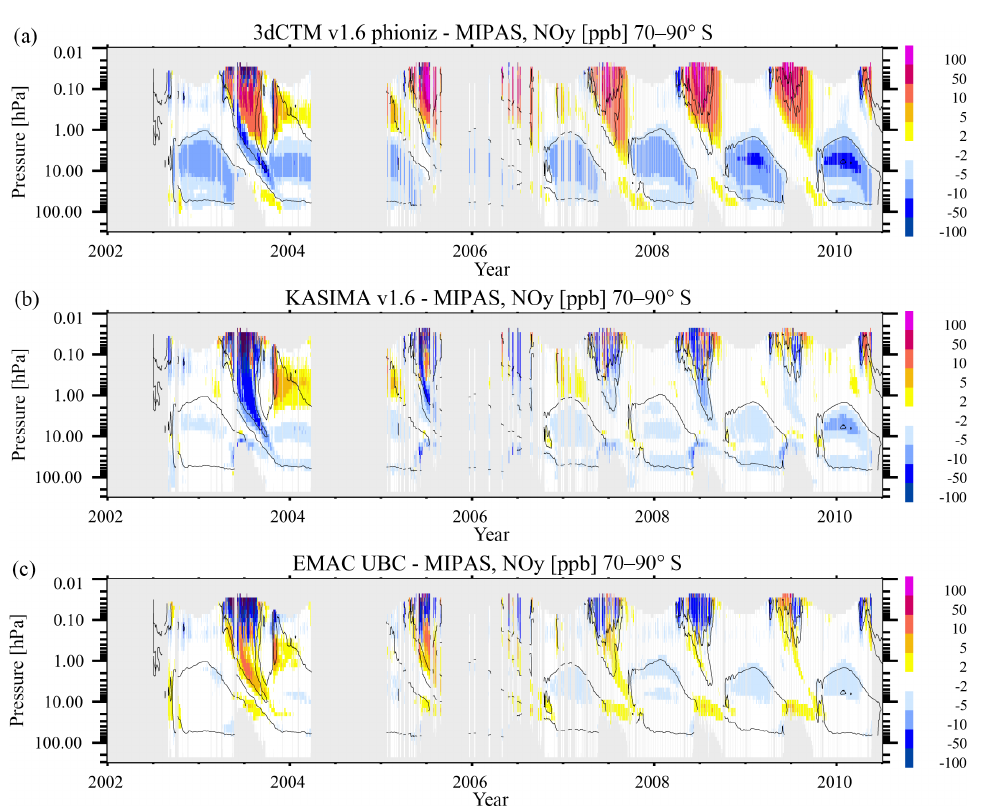
Figure 5. Absolute difference in NO y (ppb) between models and MIPAS observations at high southern (70–90 ◦ S) latitudes. Model data have been interpolated to the vertical grid of the MIPAS data, and days and altitudes are only shown where MIPAS data are available and fulfill the averaging kernel criterion. From top to bottom: 3dCTM v1.6 phioniz, KASIMA v1.6, and EMAC UBC. The black lines show the 10, 20, and 3000ppb contours of the MIPAS data, smoothed with a 7-day running mean for clarity. The gray shaded areas are periods without MIPAS data; the period before the start of the KASIMA model run is also shown in the second